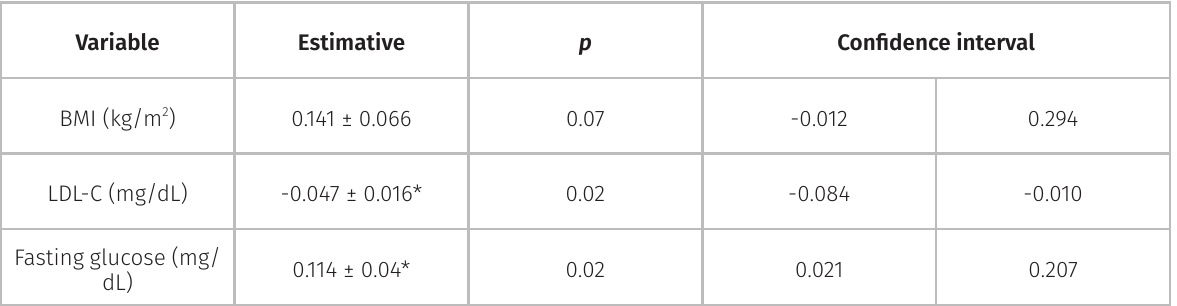
Table IV. Multiple regression analysis between FTO gene expression and BMI, LDL-C, and fasting glucose.